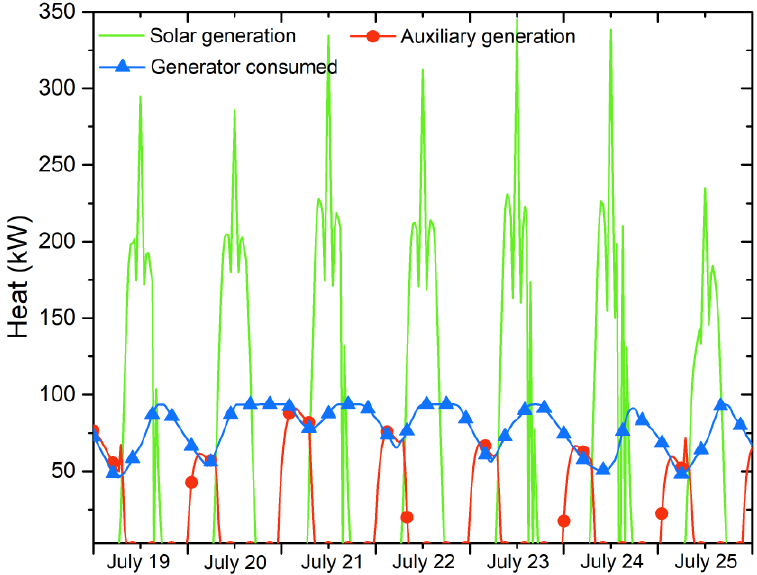
Figure 7. Variation in heat generation of the solar field and the auxiliary heater, and generator power consumption of the cooling and desalination system.